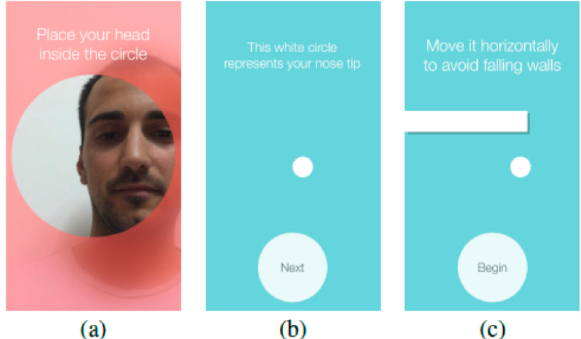
Figure 11. Screenshots of the instructions: ( a ) Instructions for the correct position for using the head-tracker (“Place your head inside the circle”); ( b , c ) Instructions explaining how to interact with the game and its objective (“The white circle represents your nose tip” “Move it horizontally to avoid falling walls”).